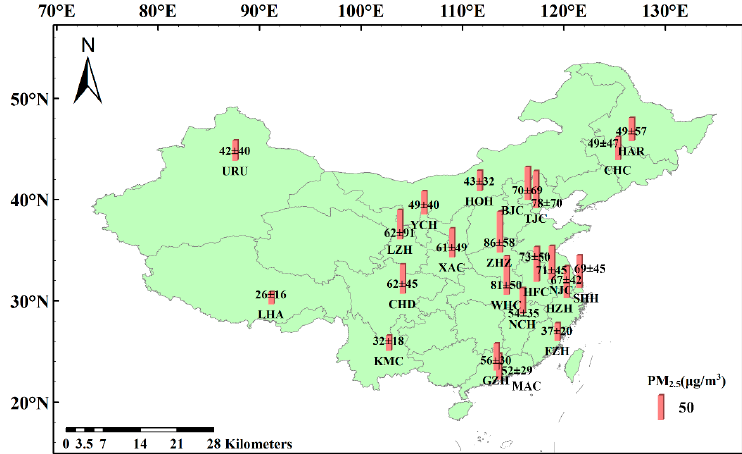
Figure 2. Spatial distribution of the annual average PM 2.5 over China from 2014 to 2015. The red pillars represent PM 2.5 , and the height of red pillar represents the annual average of PM 2.5 (unit: µ g/m 3 ).